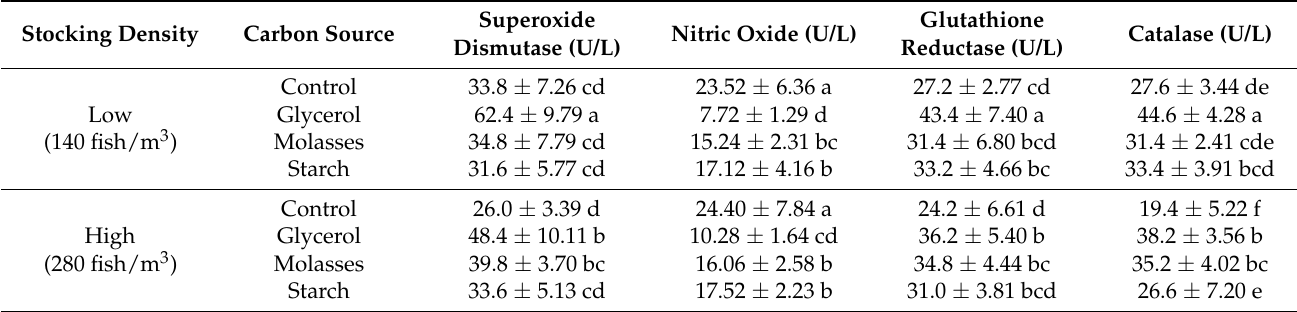
Table 4. Antioxidant levels of Nile tilapia juveniles grown at different densities in a conventional intensive culture system and outdoor biofloc technology system (mean ±